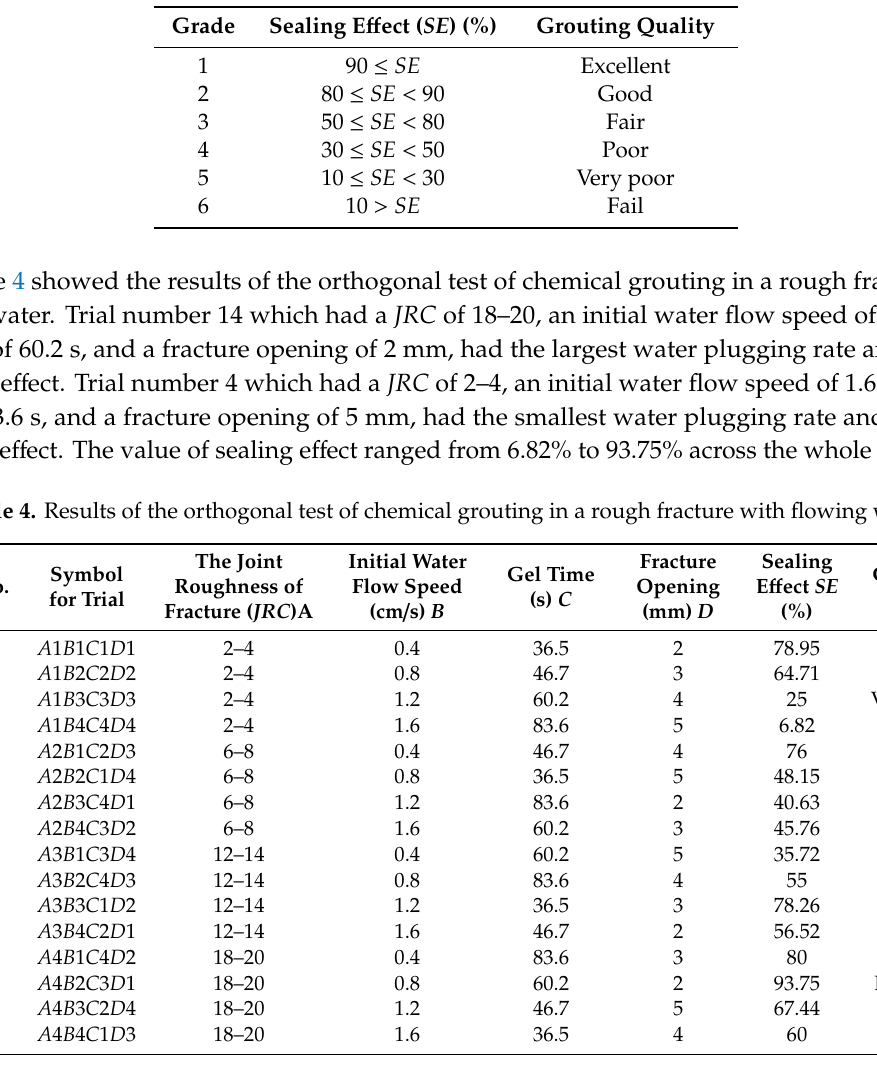
Table 3. The classification system for the grouting e ff ect proposed in this study.